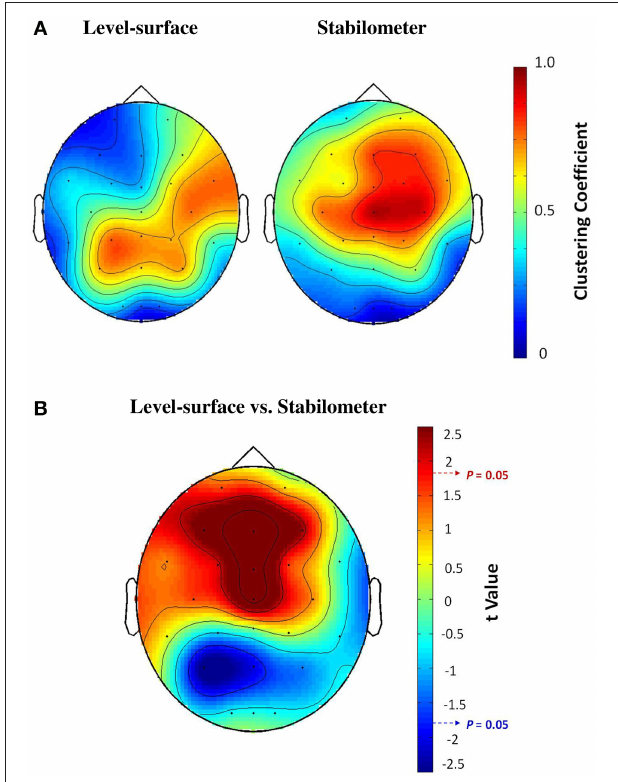
FIGURE 5 | (A) The pooled topological mapping of clustering coefficients ( C w ) between concurrent force-matching and postural tasks in the level-surface and stabilometer conditions (threshold value = 0.3). (B) The stance-dependent difference in the distribution of clustering coefficients, in terms of the topography of t -values plotted on the scalp ( t > 1.771, stabilometer C w > level-surface C w , p < 0.05; t < − 1.771, level-surface C w > stabilometer C w , p <